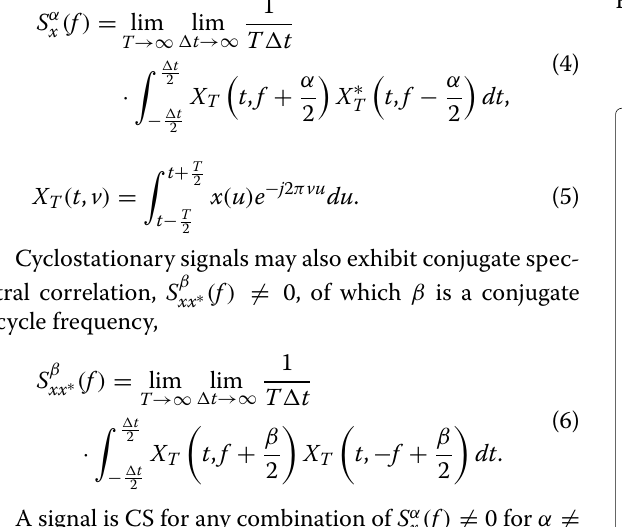
Fig. 1 The time-domain implementation of the FRESH filter from